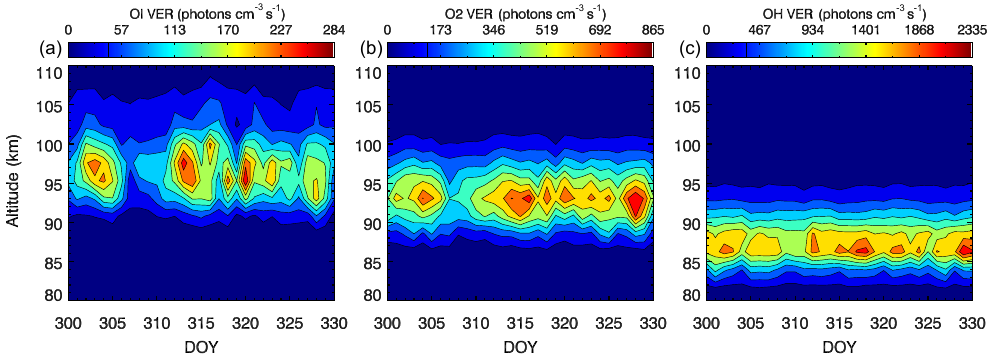
Figure 6. Time–altitude distribution of the volumetric emission rates of the OI5577 (a) , O 2 b (0–1) (b) , and OH(6–2) (c) at 43 ◦ N and 143 ◦ E. Time interval covers October and November for 2005